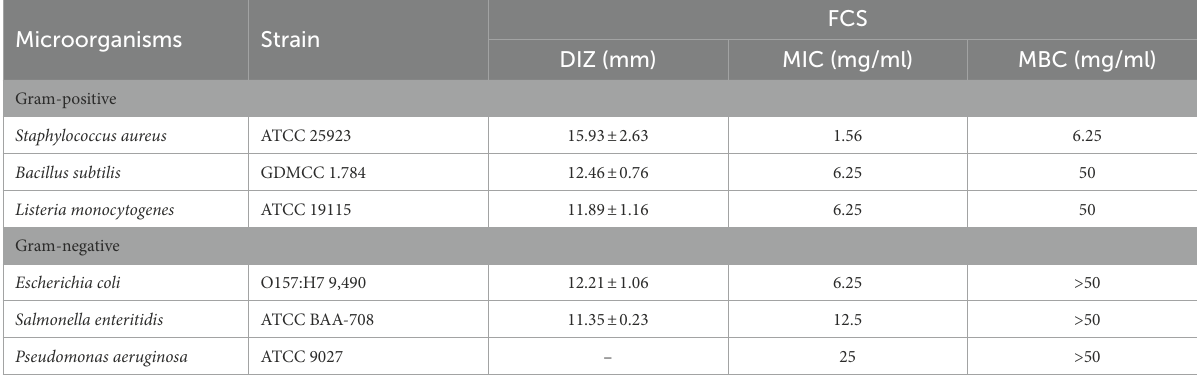
TABLE 2 Antibacterial activities of flavonoids from Chimonanthus salicifolius S. Y. Hu. against six bacteria.